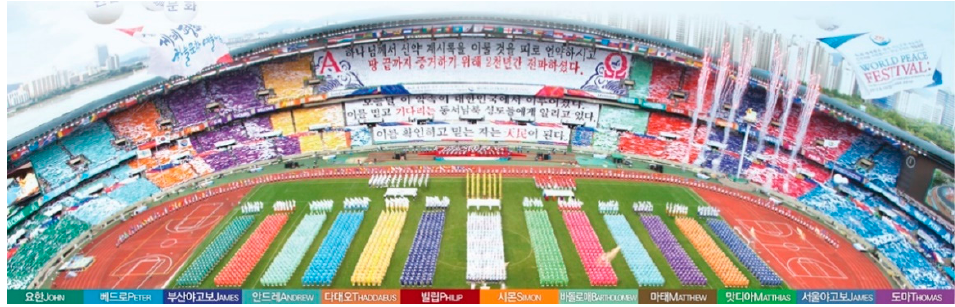
Figure 2. The 12 Tribes of Shincheonji, public domain.